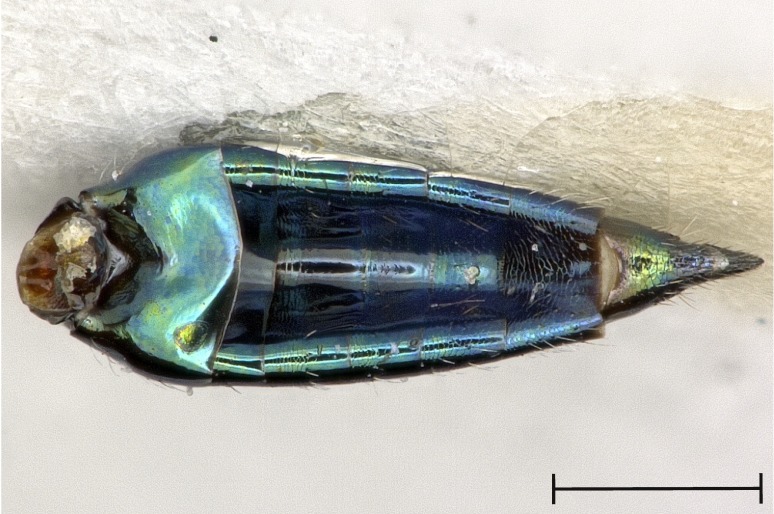
Gaster, dorsal view.